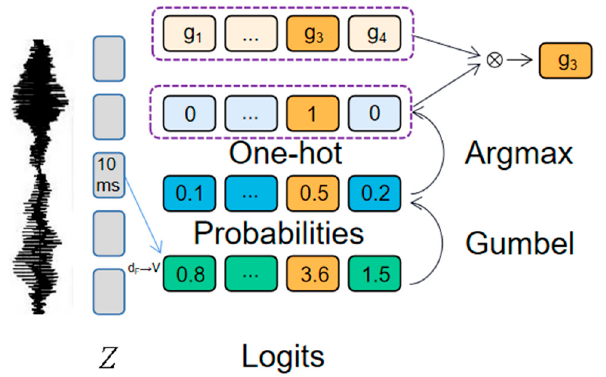
Figure 4. Gumbel